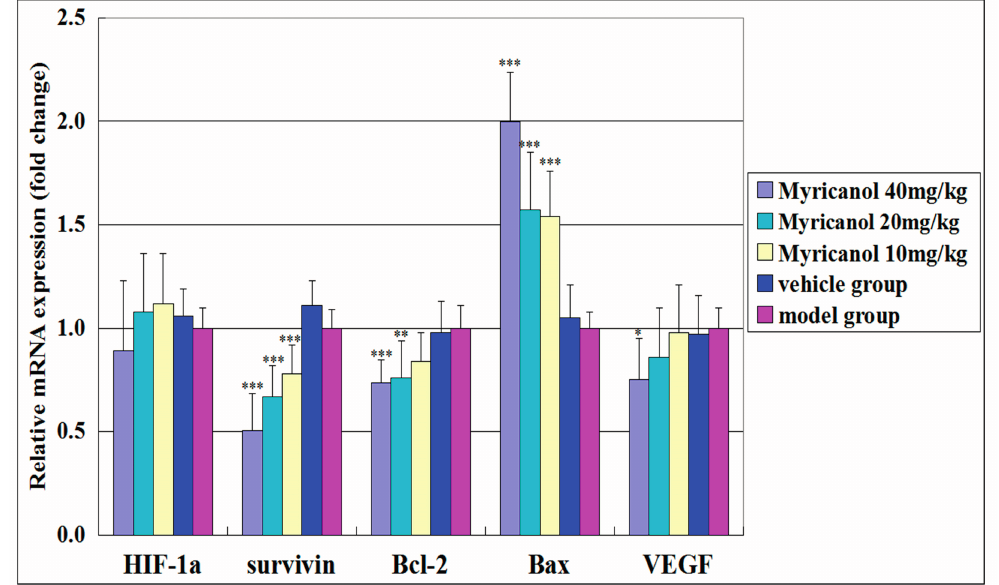
Figure 8. Effects of myricanol on the mRNA expressions of Bax, Bcl-2, VEGF, HIF-1 α , and survivin in an A549 cell xenograft model. The mRNA expression of Bax significantly increased in a dose-dependent manner after myricanol treatment; the mRNA expressions of Bcl-2, VEGF, HIF-1 α , and survivin were significantly down-regulated. These gene expression changes are implicated in the apoptotic pathway. Data are expressed as mean ± standard deviation, n = 8, * p < 0.05, ** p < 0.01, *** p < 0.001 vs. vehicle